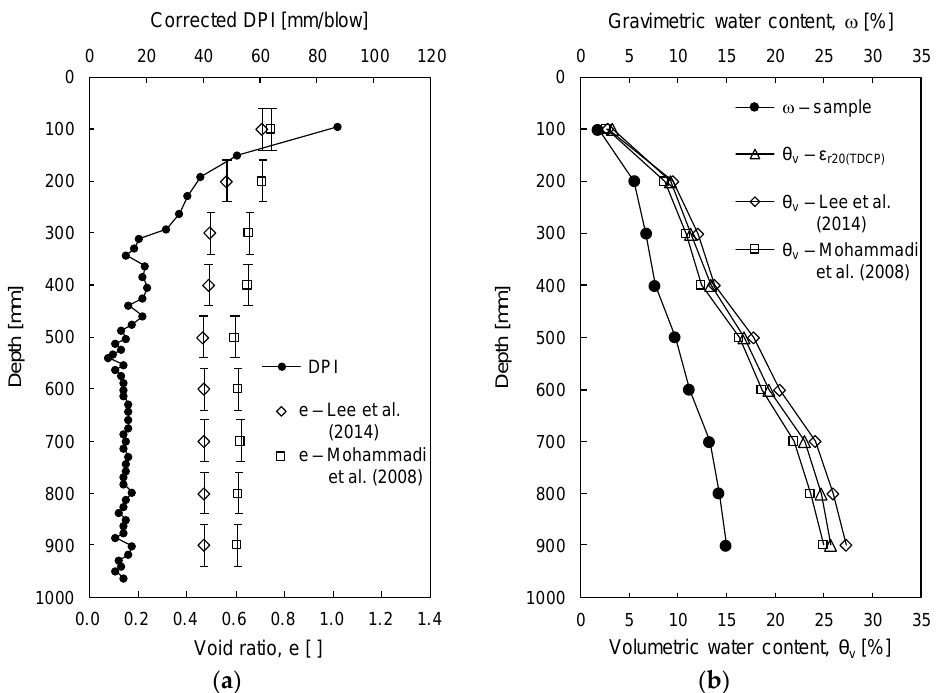
Figure 15. Verification of the experimental results: ( a ) Corrected dynamic cone penetration index (DPI) and void ratio; ( b ) Evaluated and estimated water contents.